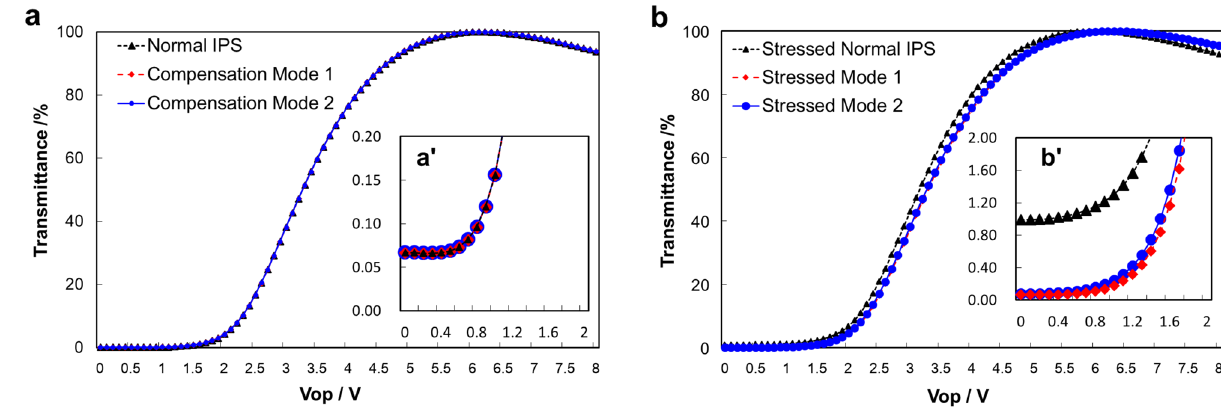
Figure 3. ( a ) The V-T curves of normal IPS, compensation mode 1 and mode 2. ( a ’) The partial enlarged V-T curves of ( a ). ( b ) The V-T curves of stressed normal IPS, stressed compensation mode 1 and mode 2. ( b ’) The partial enlarged V-T curves of ( b